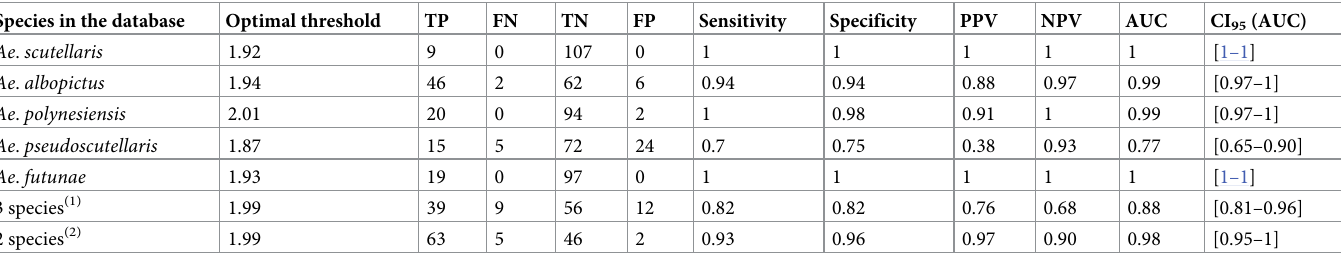
Table 3. Overview of results obtained during the determination of the optimal threshold for Aedes of the Scutellaris Group identification with MALDI-TOF MS. Species in the